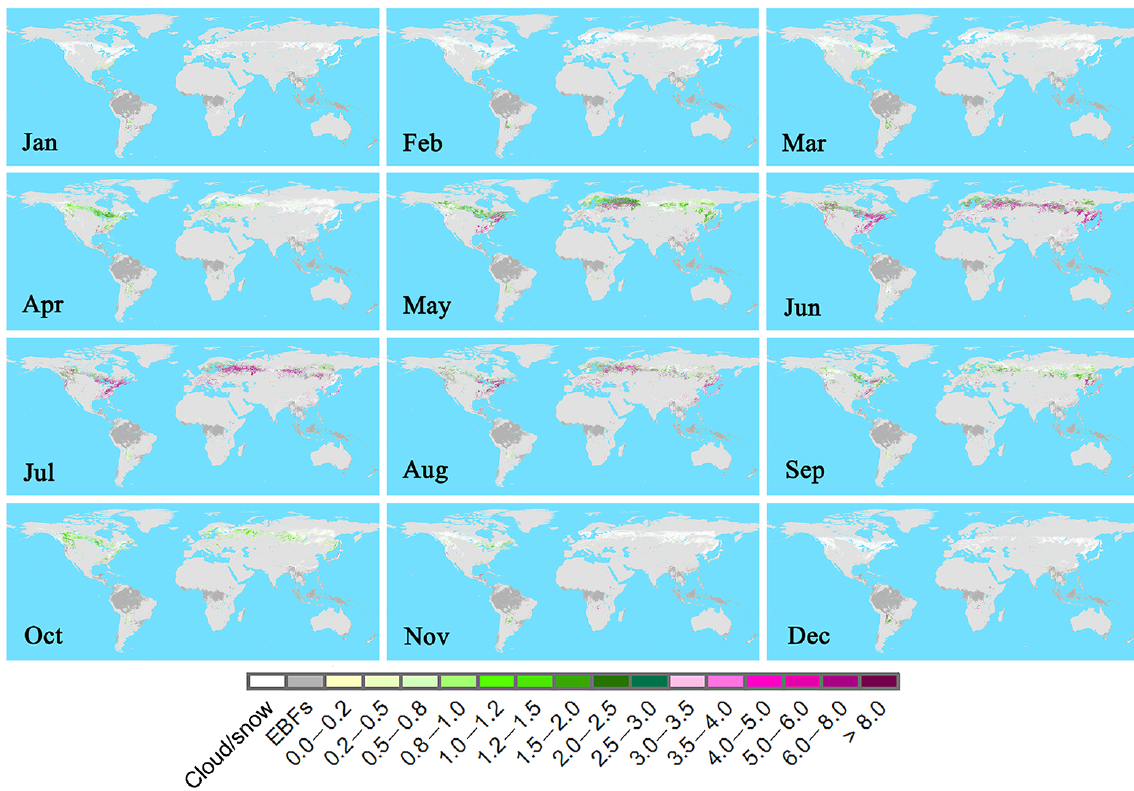
Figure 5. Global monthly GLOBMAP forest overstory LAI maps in 2010, with DOY001 for January, DOY041 for February, DOY073 for March, DOY105 for April, DOY137 for May, DOY169 for June, DOY185 for July, DOY225 for August, DOY249 for September, DOY281 for October, DOY313 for November and DOY345 for December. The results from EBFs are